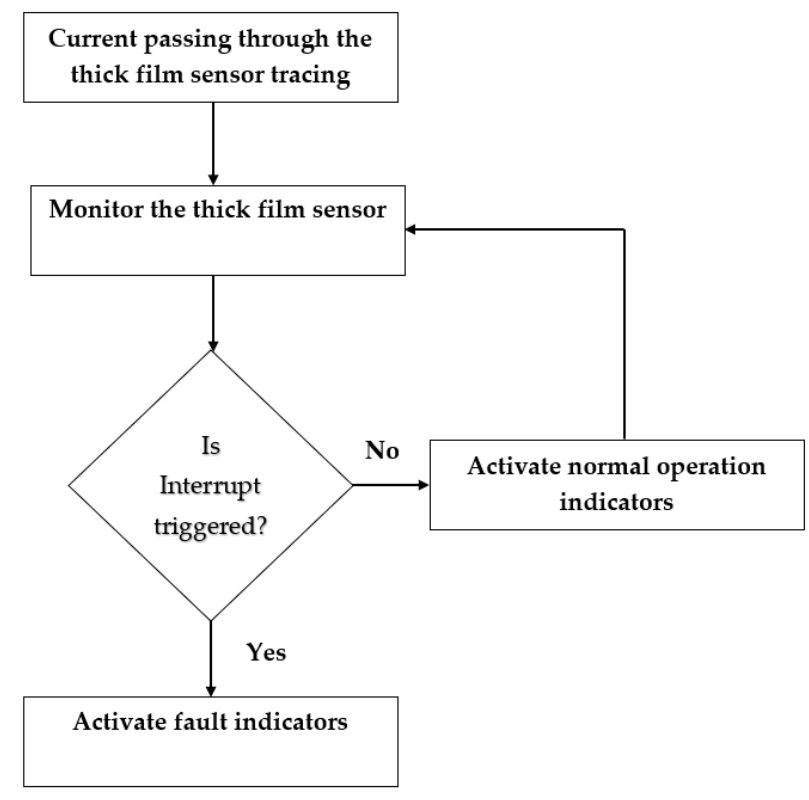
Figure 6. Flowchart for the system operation.